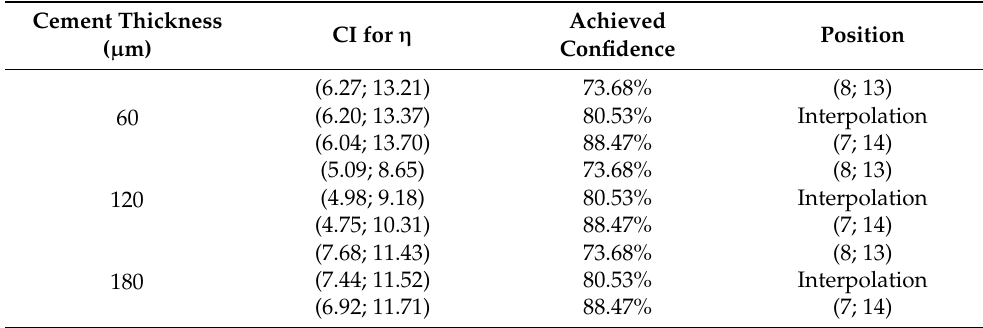
Table 4. Confidence intervals, achieved confidence and data position according to the cement layer thickness for the immediate tested groups.